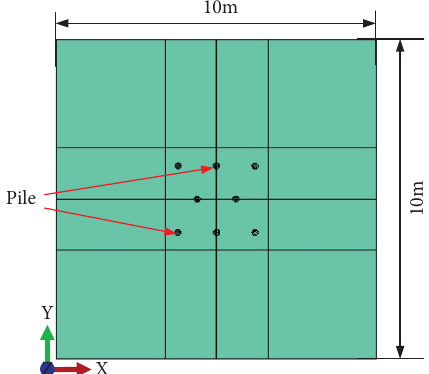
Figure 18: Pile distribution of pile group composite foundation model.